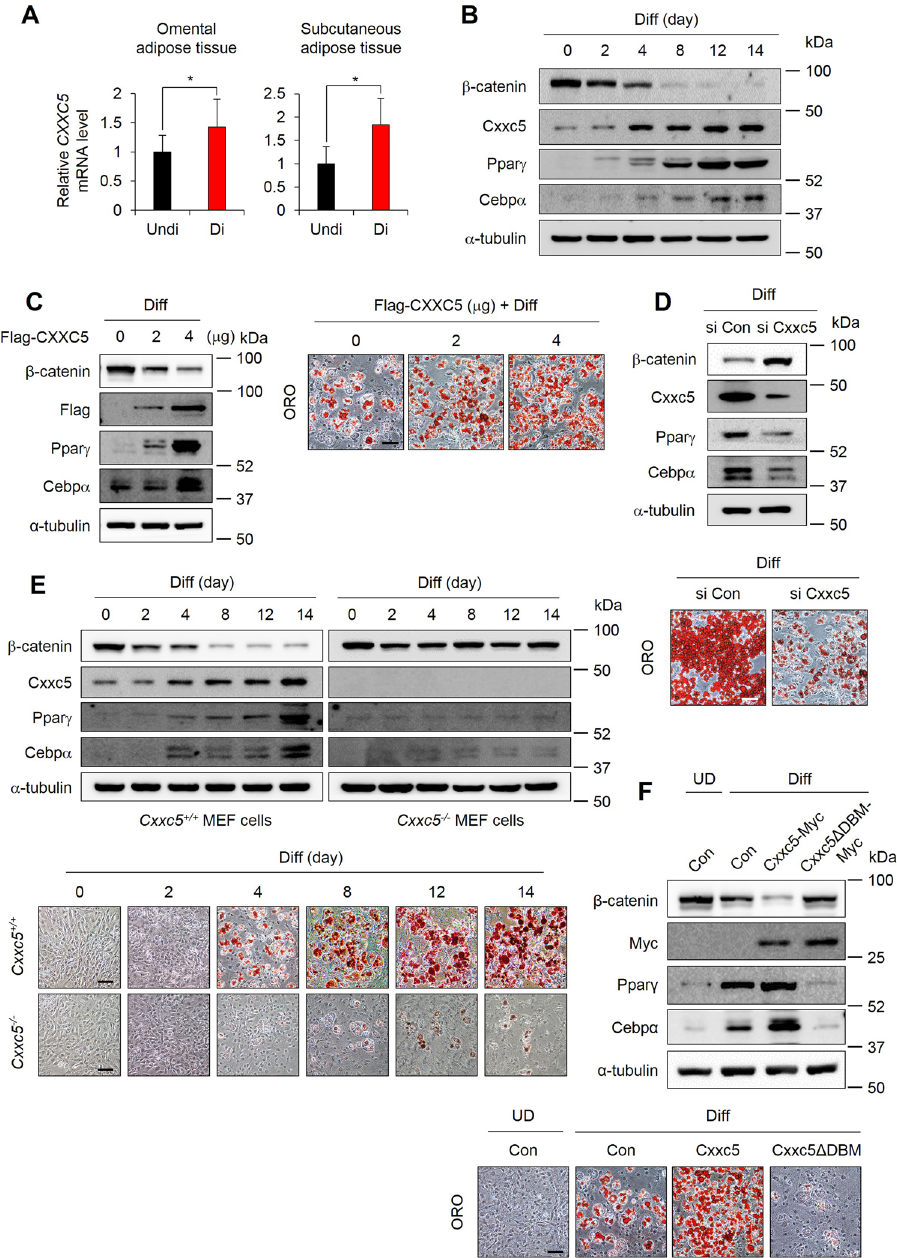
Figure 1. Inhibition of CXXC5-Dvl attenuates adipogenic differentiation in 3T3-L1 preadipocytes. ( A ) expression level of CXXC5 in undifferentiated and differentiated adipocytes of omental and subcutaneous fat pad from patients with obesity (GSE1657, n = 3 per group). ( B ) 3T3-L1 preadipocytes were time-dependently differentiated upto 14 days. ( C ) 3T3-L1 preadipocytes were transfected with pcDNA3.0-Cxxc5-Flag at a concentration of 0, 2, 4 µg then differentiated for 7 days. ( D ) 3T3-L1 preadipocytes were transfected with Cxxc5 siRNA and control siRNA then differentiated for 14 days. ( E ) Cxxc5 + / + and Cxxc5 −/− MEFs were time- dependently differentiated upto 14 days. ( F ) 3T3-L1 preadipocytes were transfected with pcDNA3.1-Cxxc5-Myc and pcDNA3.1-Cxxc5ΔDBM-Myc together with corresponding control plasmid then differentiated for 7 days. Scale bar, 100 µm. Results are expressed as mean ± SD., * P < 0.05, versus undifferentiated group. MEFs mouse embryonic fibroblasts. UD undifferentiated adipocytes, Diff differentiated